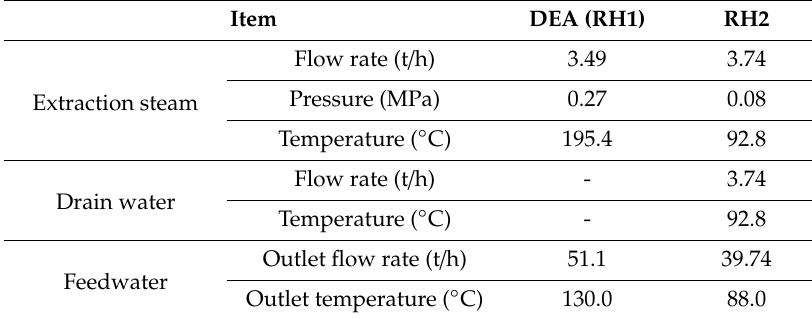
Table 2. Parameters of the heat regeneration system in the reference WtE plant. DEA: deaerator and RH: regenerative heater.